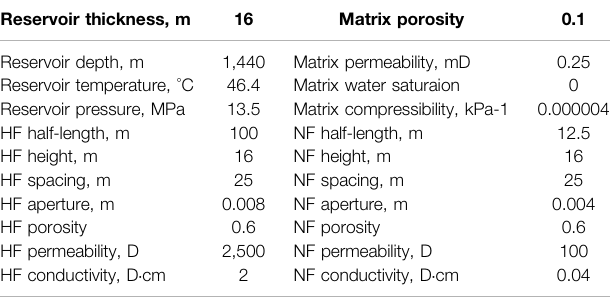
TABLE 3 | Grid properties for model B.